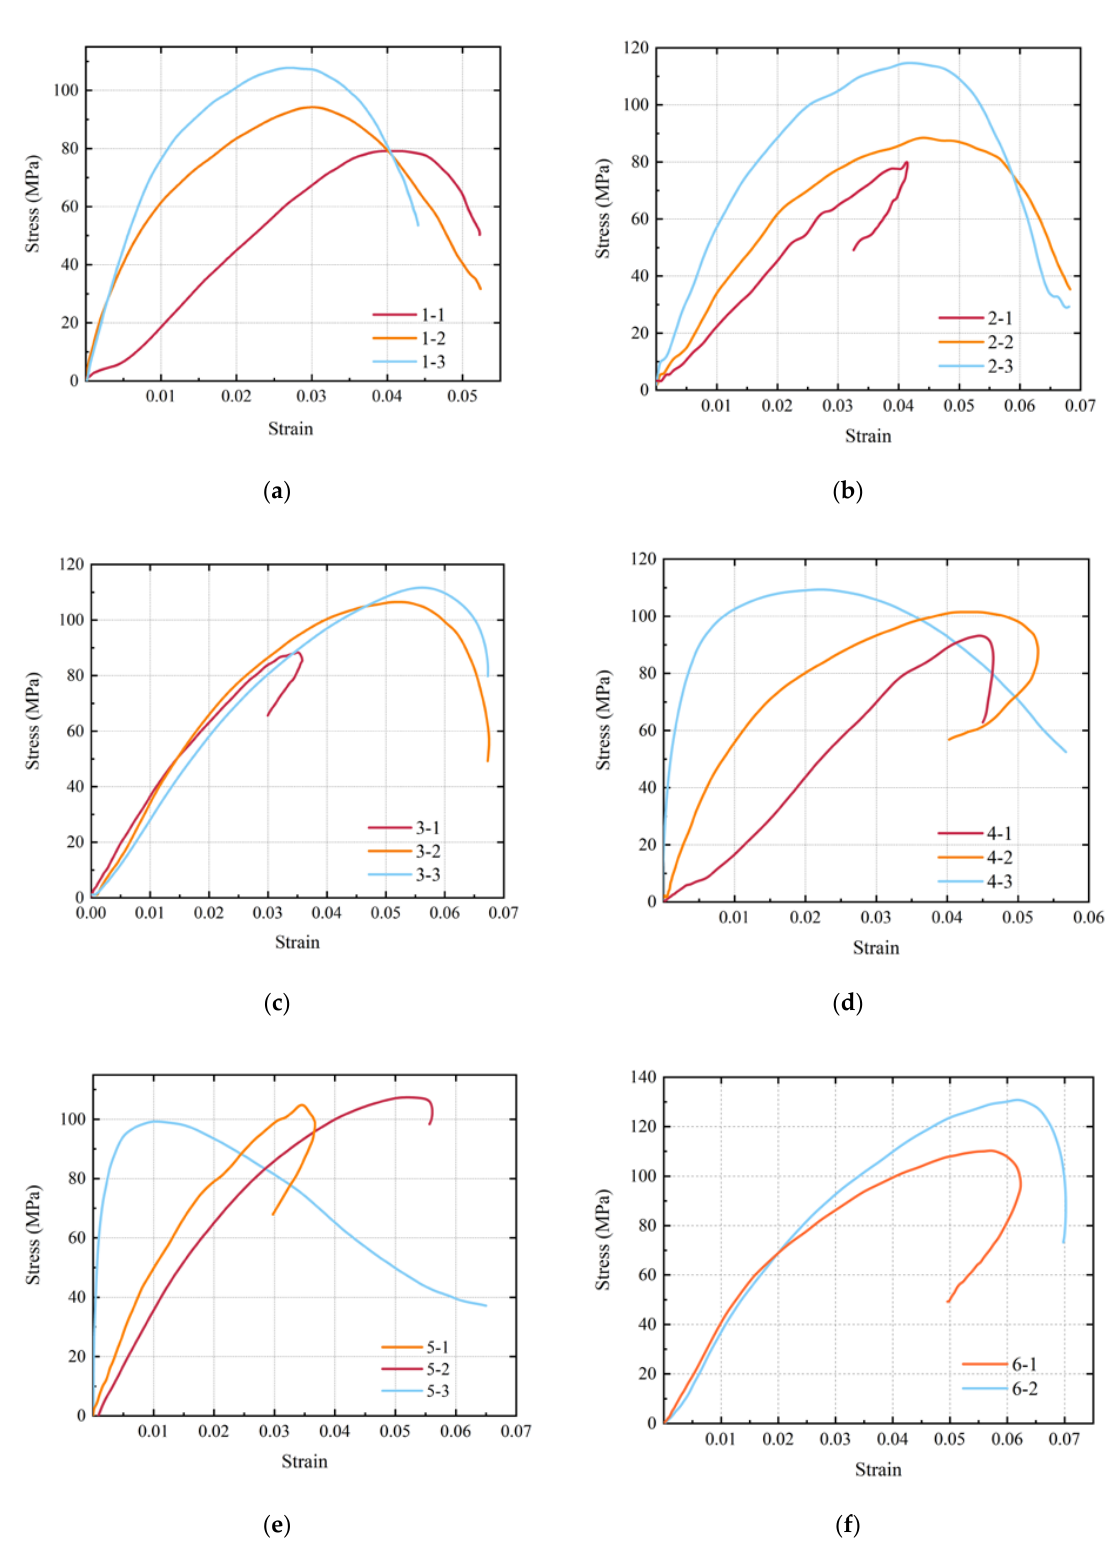
Figure 7. Stress–strain curves for coal with different loading rates at different mining depth stress fields: ( a ) 100 m: axial stress 2.7 MPa, confining stress 5.04 MPa. ( b ) 200 m: axial stress 5.4 MPa, confining stress 6.93 MPa. ( c ) 300 m: axial stress 8.1 MPa, confining stress 8.82 MPa. ( d ) 400 m: axial stress 10.8 MPa, confining stress 10.71 MPa. ( e ) 500 m: axial stress 13.5 MPa, confining stress 12.6 MPa. ( f ) 600 m: axial stress 16.2 MPa, confining stress 14.49